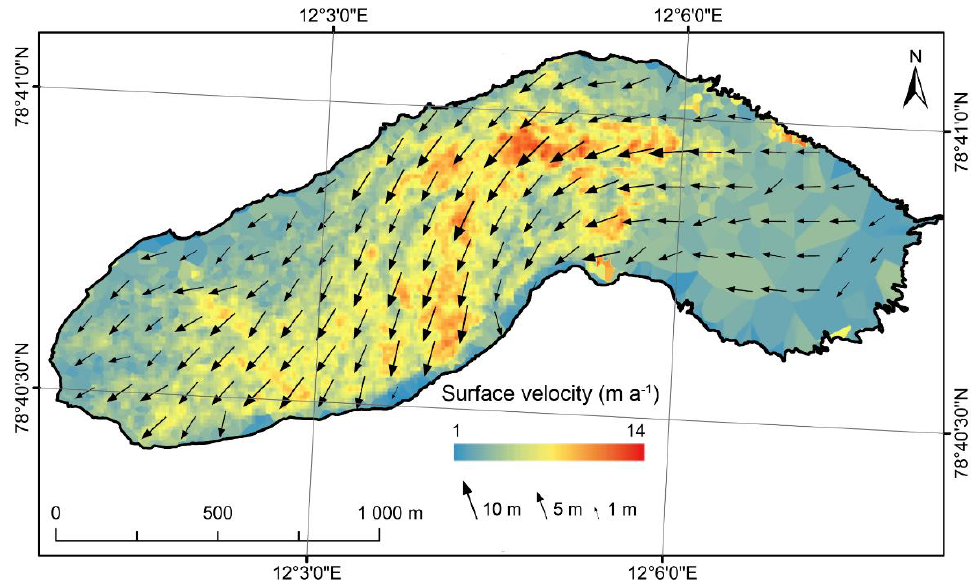
Figure 7. Surface velocity and displacement vectors of Waldemarbreen calculated from hillshade rasters (2019 and 2021). rasters (2019 and